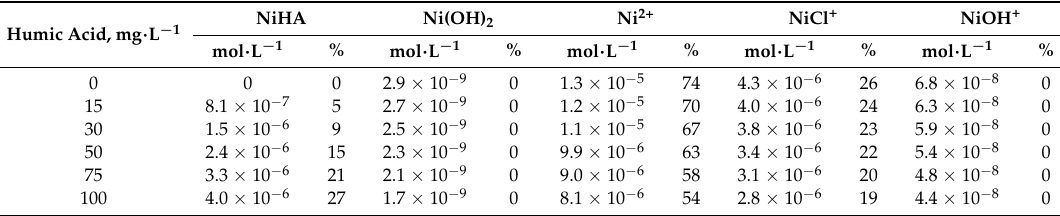
Table 1. Nickel species' distribution in the source solution for different HA concentrations was calculated with the WinHumicV software. Source solution: 1 mg · L − 1 Ni 2+ , 35 g · L − 1 NaCl, 0.25 mol · L − 1 HEPES, pH 8.